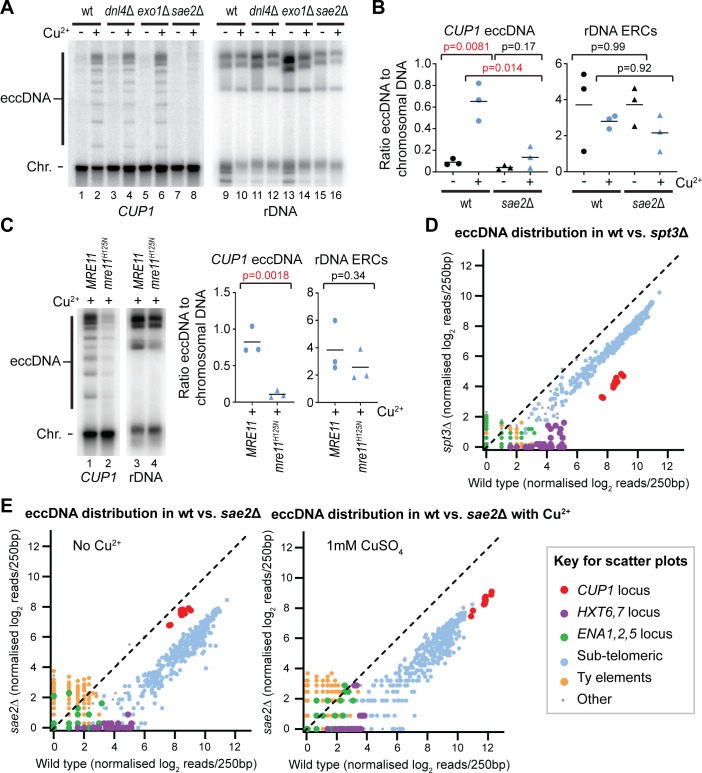
Sae2 and Mre11 nuclease activity are required for eccDNA formation.(A) Southern blot analysis of CUP1 eccDNA and rDNA-derived ERCs in wt, dnl4Δ, exo1Δ, and sae2Δ cells aged for 24 hours in the presence or absence of 1 mM CuSO4, performed as in Fig 1B. (B) Analysis of CUP1 eccDNA and rDNA-derived ERCs in wt and sae2Δ cells aged for 24 hours in the presence or absence of 1 mM CuSO4, performed and analysed as in Fig 1B; n = 3; quantification is derived from 3 separate clones of sae2Δ with 3 different selectable markers. (C) Analysis of CUP1 eccDNA and rDNA-derived ERCs in wt and mre11H125N/mre11Δ aged for 24 hours in the presence of 1 mM CuSO4, performed and analysed as in Fig 1B, n = 3. (D) REC-seq analysis comparing wt and spt3Δ cells aged for 24 hours. Samples were digested with restriction enzymes that leave the 2μ DNA intact, and then read counts were normalised based on 2μ counts in eccDNA and matching total DNA libraries such that eccDNA counts are relative to an equivalent quantity of total chromosomal DNA in each sample. Reads are quantified in 100 bp windows spanning the genome (excluding rDNA, mitochondria, 2μ, and UBC9 locus), and coloured by feature according the key below. (E) REC-seq analysis of sae2Δ cells compared to wt in the absence (left) or presence (right) of 1 mM CuSO4. Experiment and analysis as in panel D. The data underlying this figure may be found in S1 Data and S1 Raw Images. eccDNA, extrachromosomal circular DNA; ERC, extrachromosomal ribosomal DNA circle; rDNA, ribosomal DNA; REC-seq, restriction-digested extrachromosomal circular DNA sequencing; wt, wild type.